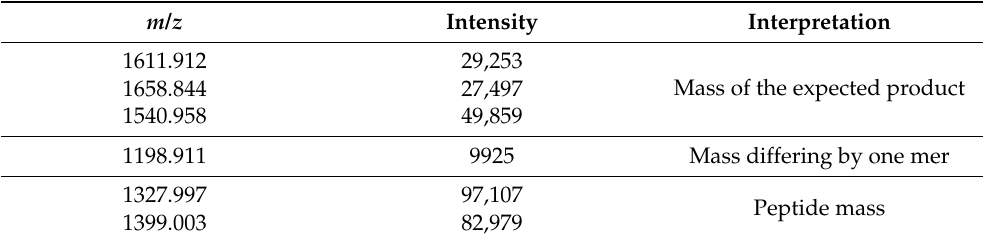
Table 1. Analysis of the characteristic peaks from the MS spectrum of the obtained polysaccharide– H-KRMVRISRSL-OH conjugate.